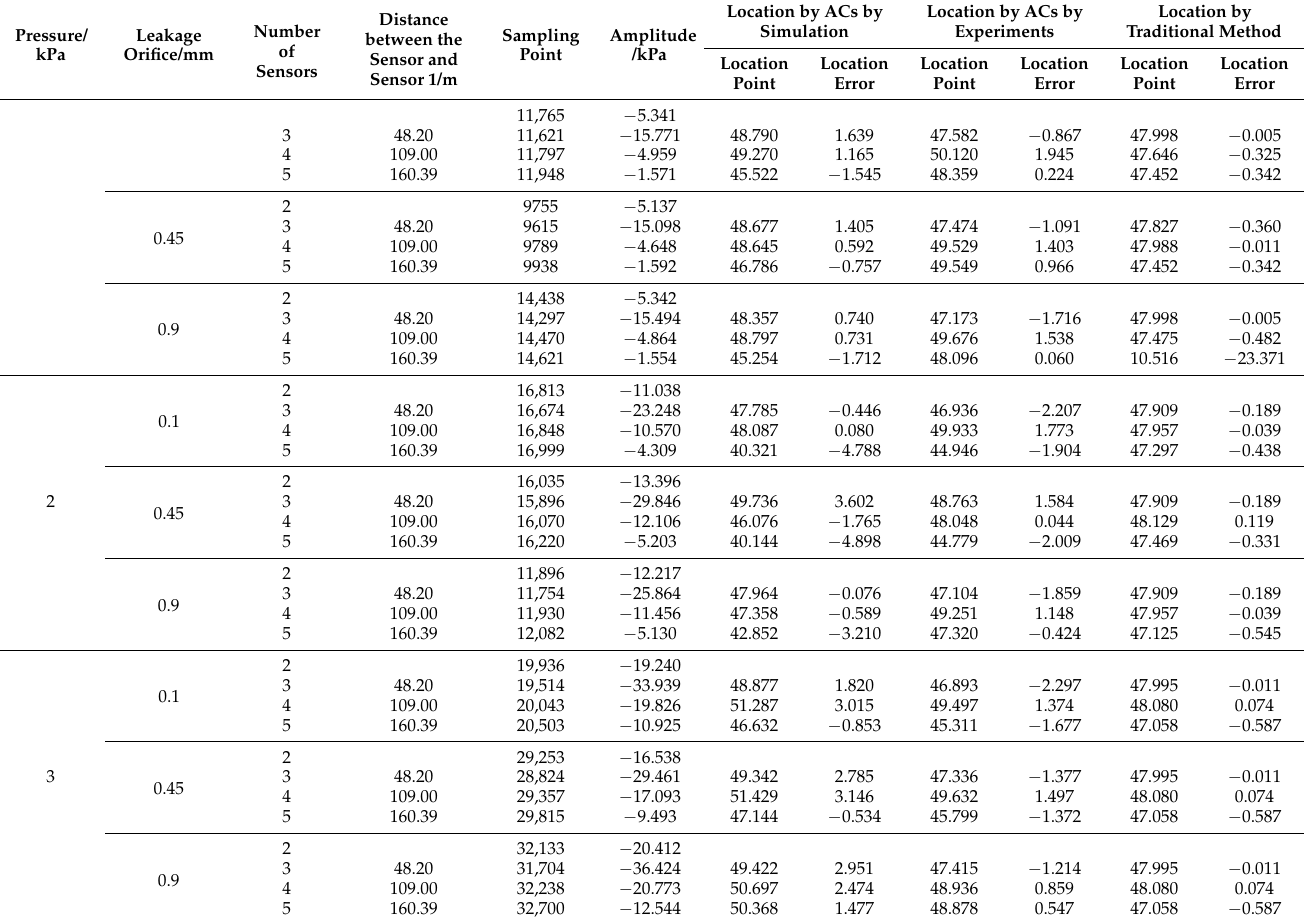
Table 12. Leak location results based on propagation